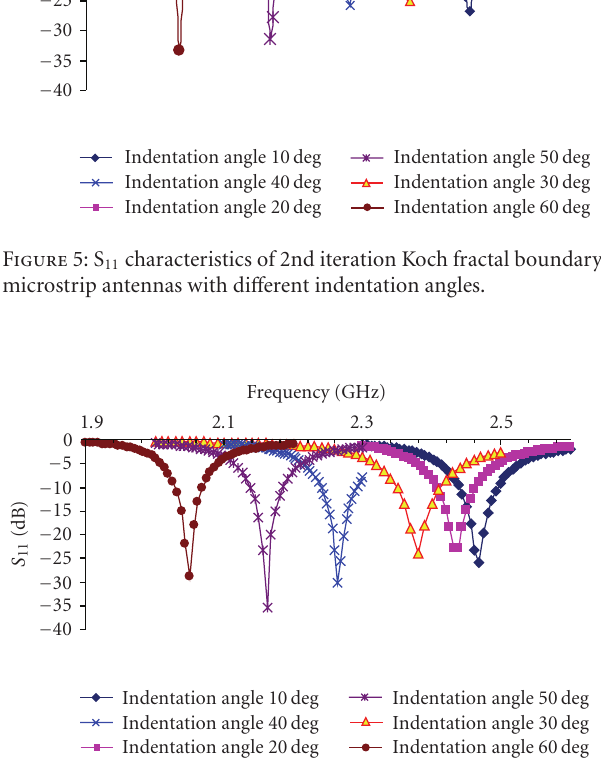
Figure 6: S 11 Characteristics of 3rd iteration Koch fractal boundary microstrip antennas with di ff erent indentation